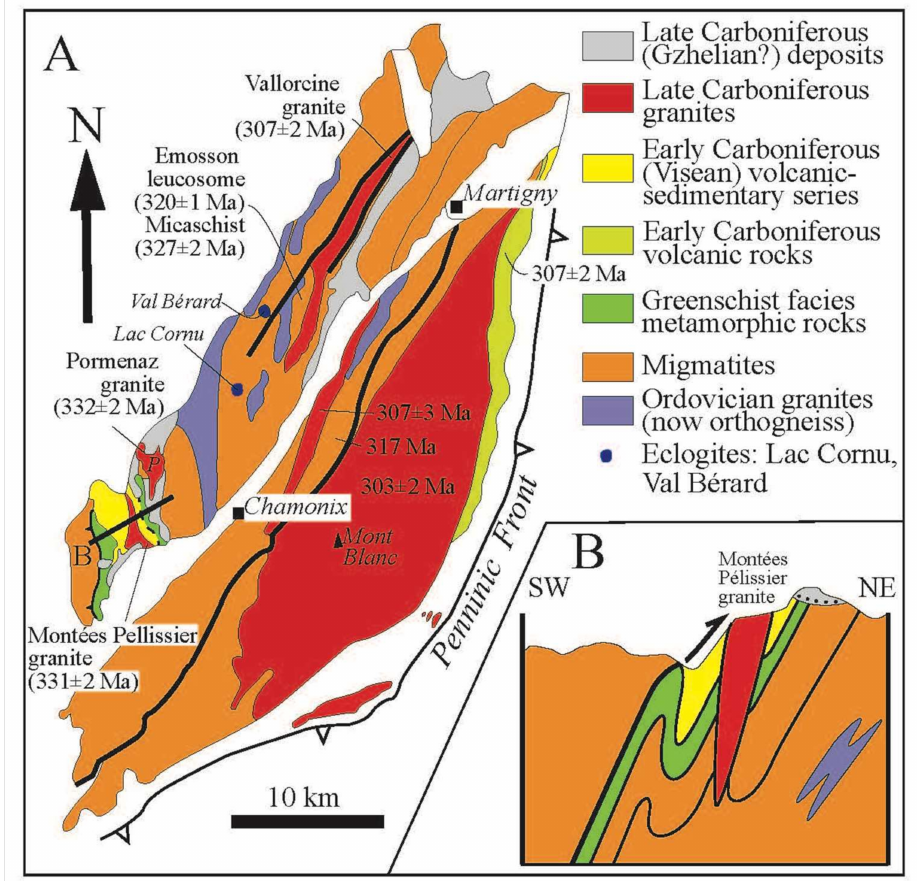
Figure 7. ( A ): structural map of the Mont-Blanc-Aiguilles Rouge massifs, and ( B ): cross-section of the Southwestern part of the Aiguilles Rouges massif (redrawn from [61]). This massif does not show any ophiolitic suture, but only eclogite derived from Ordovician mafic protoliths (gabbro, dyke, and lava flow) intrusive into a pelitic-sandstone formation. Ordovician granites are also intrusive in this series. Fold vergence and thrusts document NE-directed kinematics older than the 332 ± 2 Ma (Late Visean) plutons